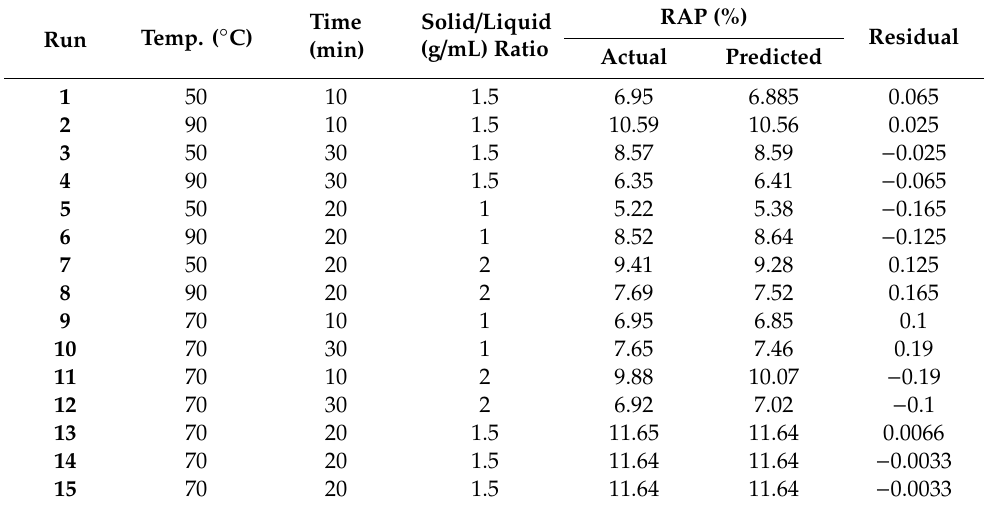
Table 1. The Box–Behnken response surface design and corresponding response values.